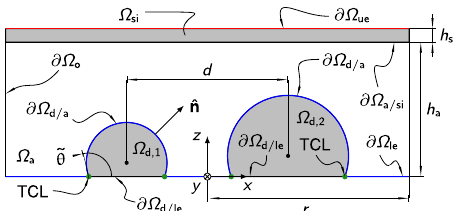
Fig. 6 Schematic cross-sectional view of the three-dimensional computational domain with all relevant dimensions. The domain is cut along the symmetry xz -plane. Domains and boundaries are denoted as Ω and ∂ Ω , respectively. The idealized three-phase contact lines (TCL) of both droplets are highlighted by green dots. Between the boundaries ∂ Ω ue (red) and ∂ Ω le ∪ ∂ Ω d/a (blue) a potential difference Δ ϕ is applied. The sketch is not to scale, in particular the outer boundaries ∂ Ω o are actually placed far away from the droplets (see also Fig.